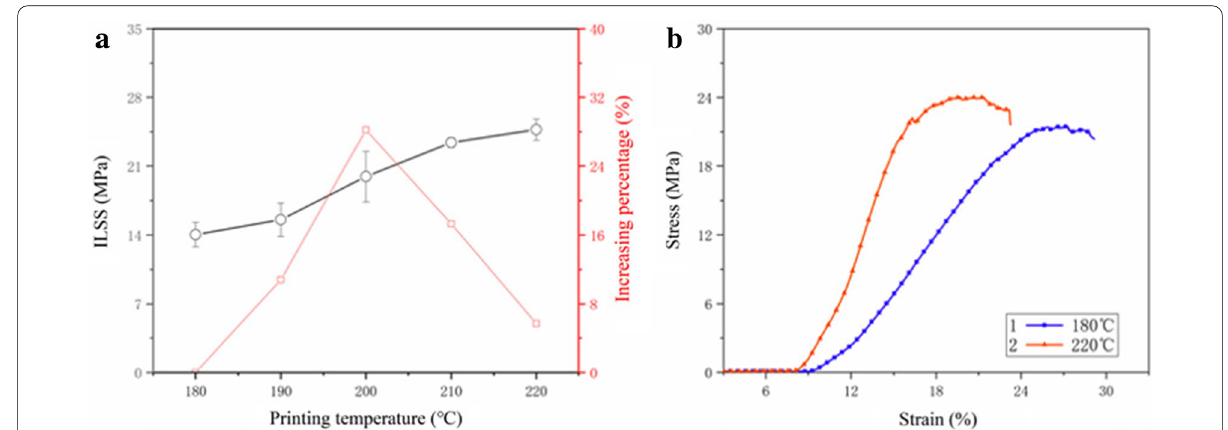
Figure 5 Effect of nozzle temperature on ILSS: a ILSS value variation, b stress-strain